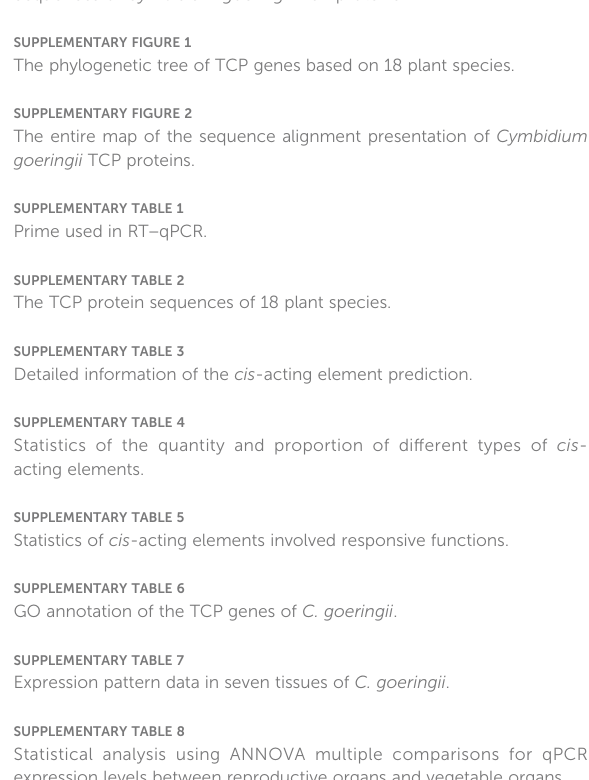
SUPPLEMENTARY FIGURE 1 The phylogenetic tree of TCP genes based on 18 plant species. SUPPLEMENTARY FIGURE 2 The entire map of the sequence alignment presentation of Cymbidium goeringii TCP proteins. SUPPLEMENTARY TABLE 1 Prime used in RT − qPCR. SUPPLEMENTARY TABLE 2 The TCP protein sequences of 18 plant species. SUPPLEMENTARY TABLE 3 Detailed information of the cis -acting element prediction. SUPPLEMENTARY TABLE 4 Statistics of the quantity and proportion of different types of cis - acting elements. SUPPLEMENTARY TABLE 5 Statistics of cis -acting elements involved responsive functions. SUPPLEMENTARY TABLE 6 GO annotation of the TCP genes of C. goeringii . SUPPLEMENTARY TABLE 7 Expression pattern data in seven tissues of C. goeringii . SUPPLEMENTARY TABLE 8 Statistical analysis using ANNOVA multiple comparisons for qPCR expression levels between reproductive organs and vegetable